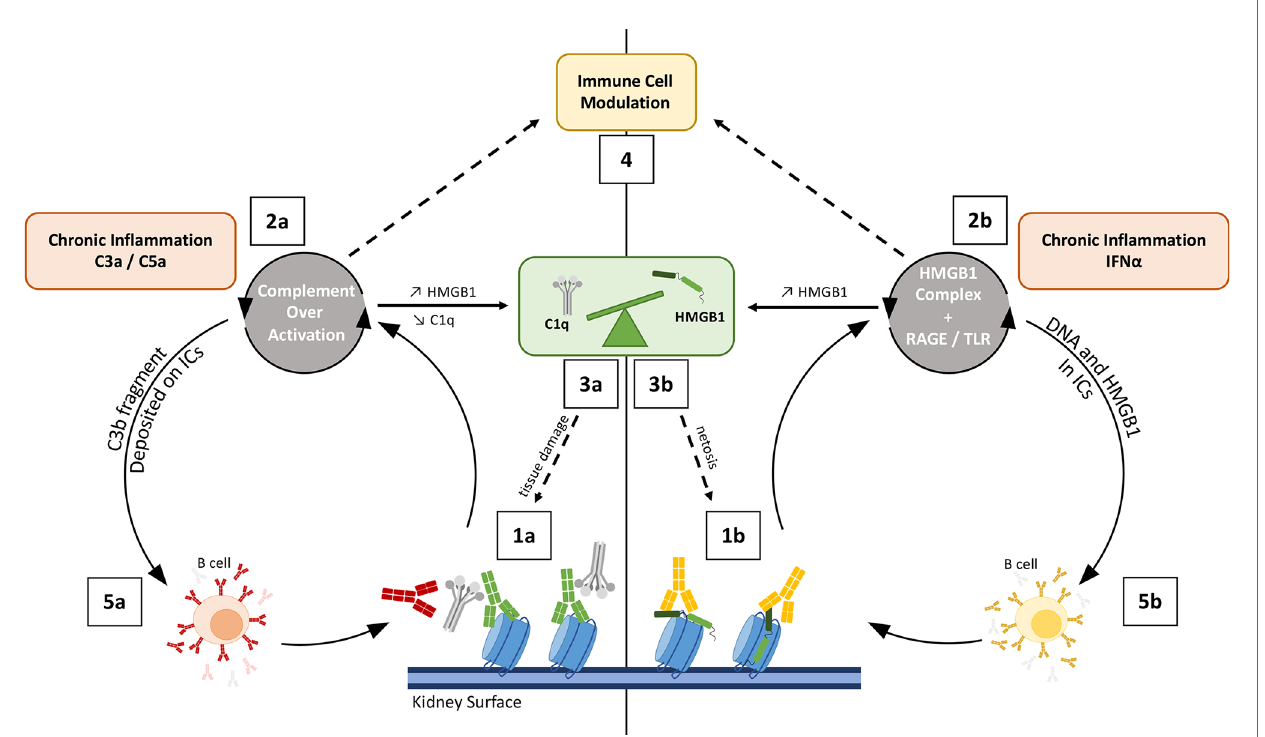
FIGURE 5 | Schematic view on how complement and HMGB1 may co-amplify tissue damaging feedback loops in SLE/LN. Left: Complement overactivation (1a to 5a); Right: HMGB1-mediated impact (1b to 5b). On the left side, complement over-activation (through C1r/s, not shown) by intrarenal deposited immune complexes is enhanced by anti-C1q (red) (1a). This leads to C3a-C5a driven in fl ammation (2a) and renal tissue damage, with impaired clearance because of C1q and C3 depletion, therefore releasing more nucleosomes (3). On the right side, HMGB1 forms complexes with nucleosomes (1b), LPS or cytokines. These HMGB1 complexes enhance in fl ammation in the kidney or in the skin of lupus patients, and activate IFN- a production (a driving cytokine in lupus pathogenesis, 2b). Both HMGB1 and C3a/C5a can stimulate HMGB1 release by activated cells (2a, 2b); HMGB1 is also passively released by complement-damaged cells (3a), and through increased netosis induced by HMGB1 (3b). The consequent imbalance effect on C1q and HMGB1 hampers proper in fl ammation resolution (see Figure 6 ) (4). On both sides, the process stimulates B-cells to produce more auto-Abs, which fuels the two combined vicious circles at the fi rst steps (5a, 5b). Different types of auto- Abs are illustrated, with possible functional interference: anti-nucleosome (green), anti-C1q (red), anti-HMGB1